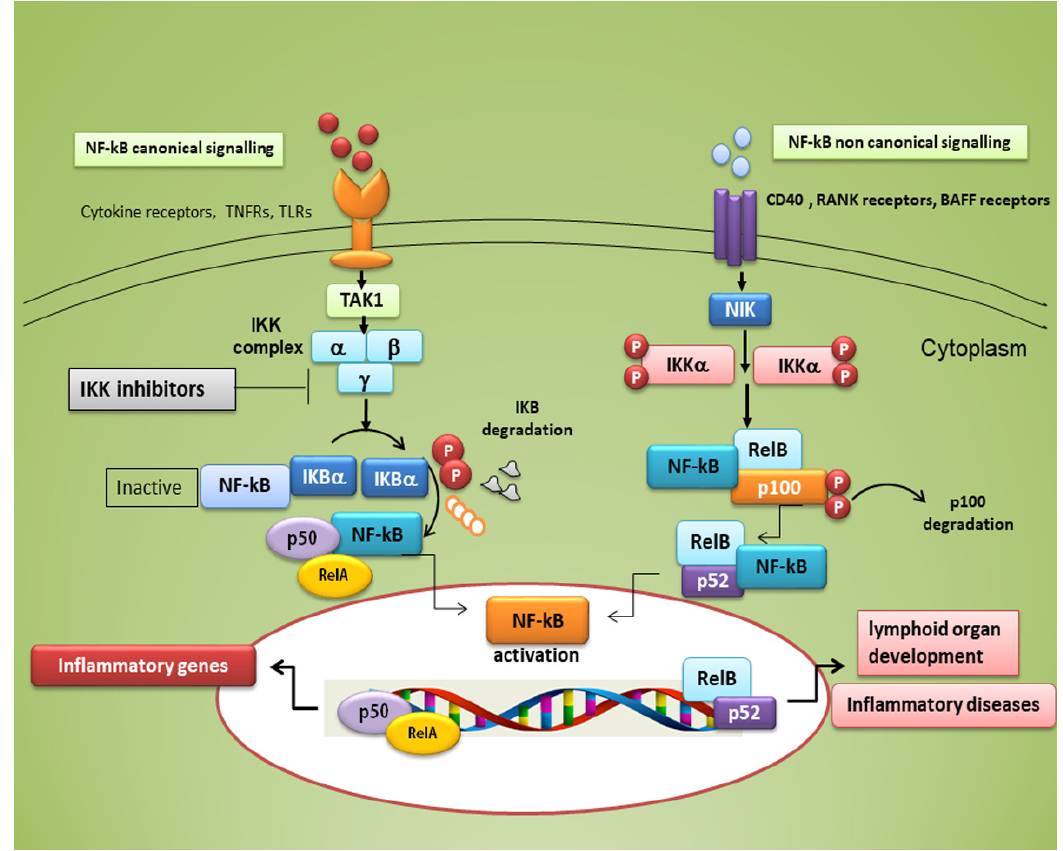
Figure 1. Canonical and non-canonical nuclear factor κ (kappa)-light-chain-enhancer of activated B cells (NF- κ B) signalling pathways. The canonical NF- κ B pathway starts with the activation of innate and adaptive immune receptors in response to various ligand molecules, which transfers the signal across the cell membrane causing the activation of the trimeric I κ B kinase (IKK) complex, composed of catalytic (IKK α and IKK β ) and regulatory (IKK γ ) subunits. The IKK complex phosphorylates I κ B α and phosphorylated I κ B undergo ubiquitylation and proteasomal degradation, allowing nuclear translocation of the RelA/p50 dimer of the NF- κ B heterodimer. The non-canonical NF- κ B pathway selectively responds to a subset of TNFR members that induce the activation of the NF- κ B-inducing kinase (NIK). NIK phosphorylates and activates IKK α , which in turn phosphorylates carboxy-terminal serine residues of p100, triggering selective degradation of the C-terminal I κ B-like structure of p100, and mediates the persistent activation of the RelB/p52 complex.